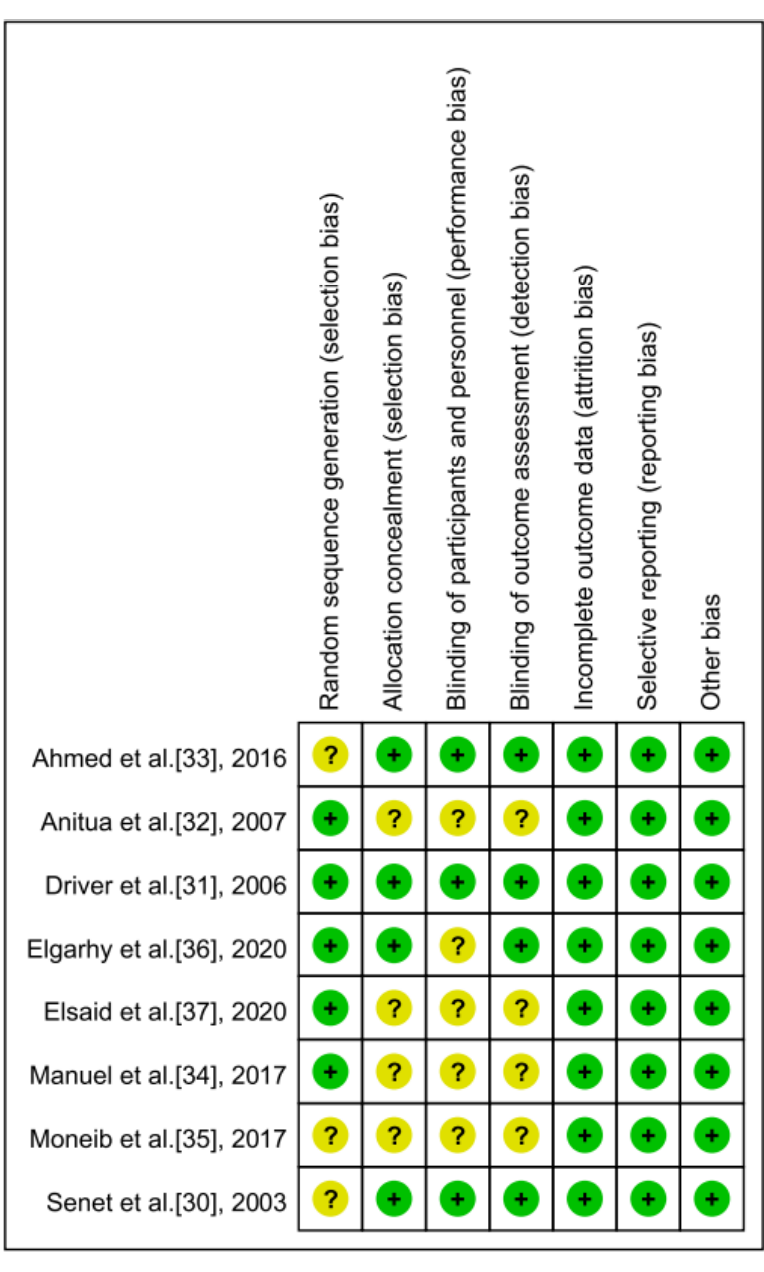
Figure 2. The risk of bias in all enrolled studies.